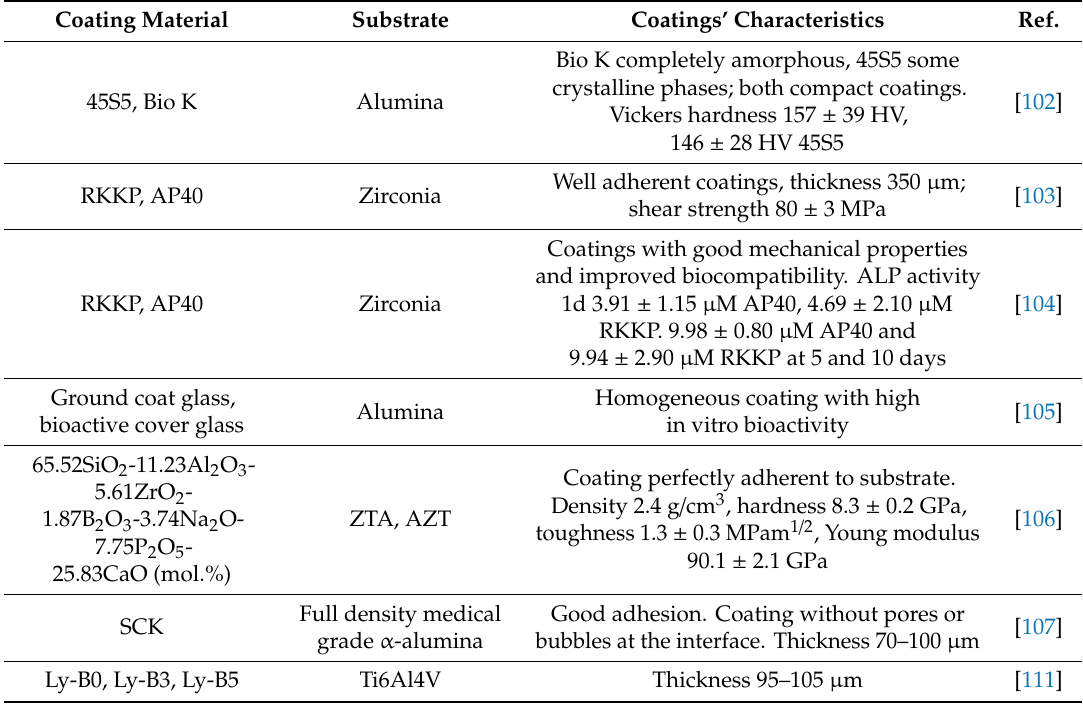
Table 2 summarizes the di ff erent bioactive glass coatings obtained by enamelling technique. Table 2. Summary of bioactive glass coatings obtained by enamelling